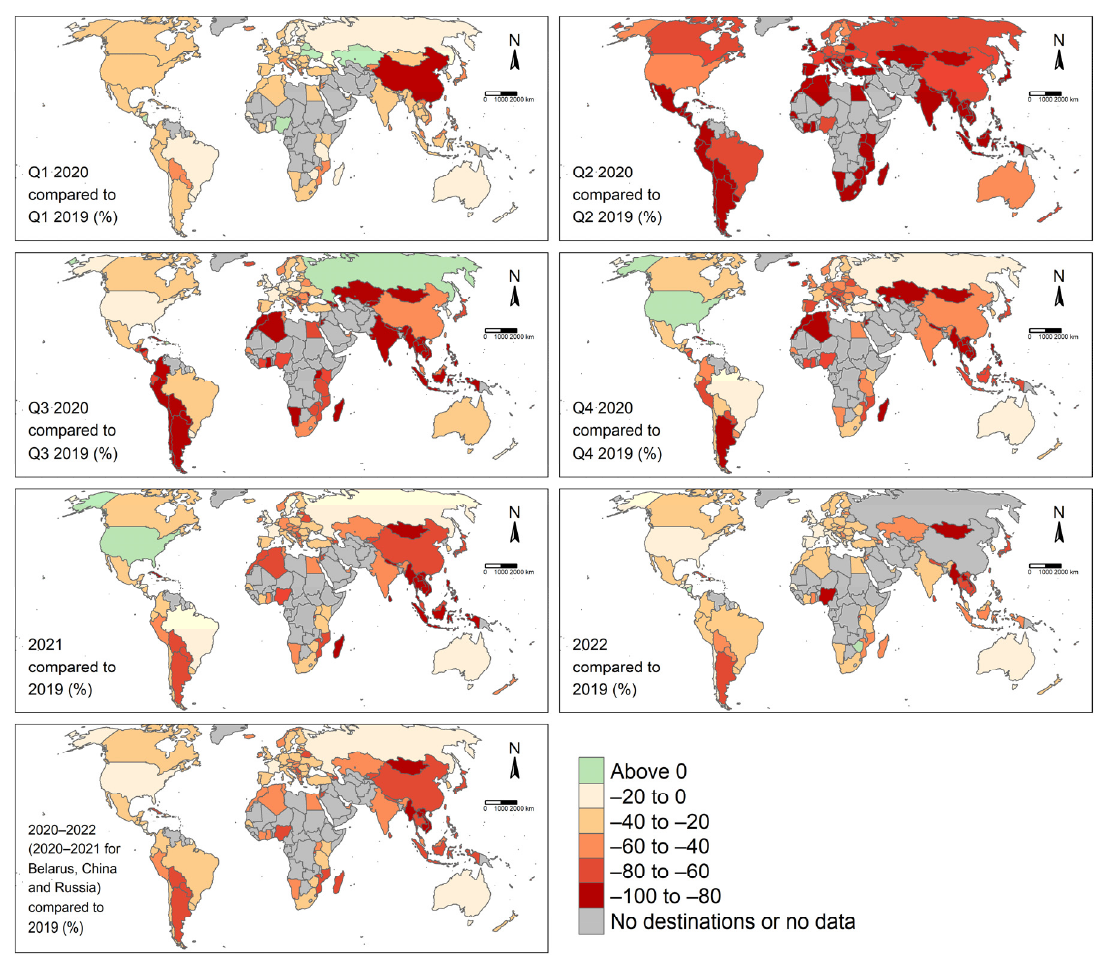
Figure 5. Median change in the number of reviews in destinations by country.